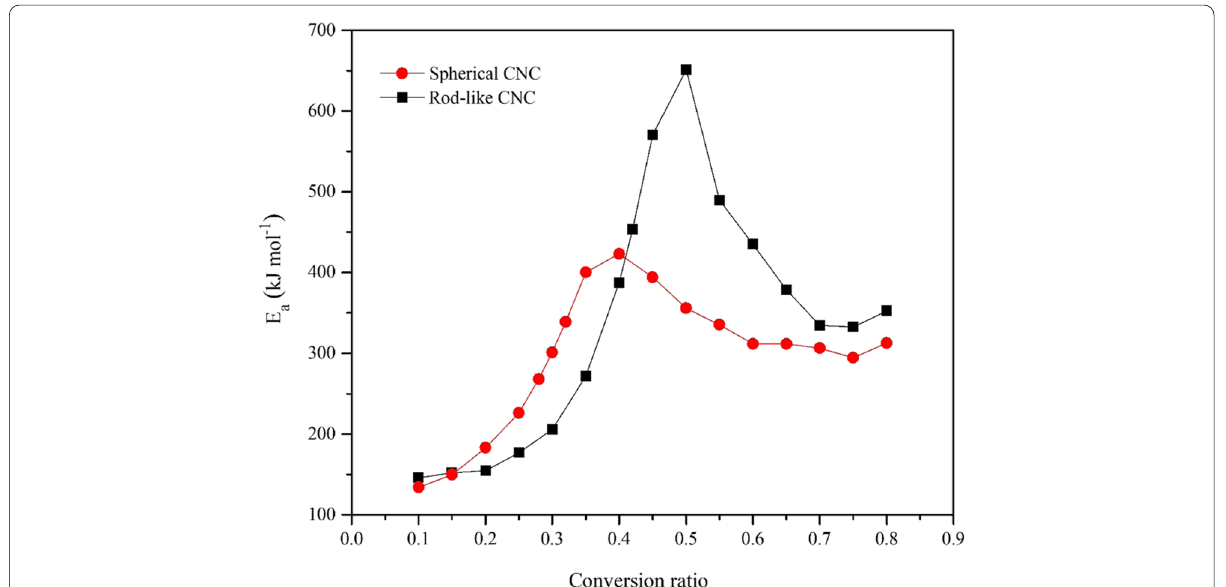
Fig. 8 Activation energy versus conversion ratio for spherical CNC and rod-like CNC